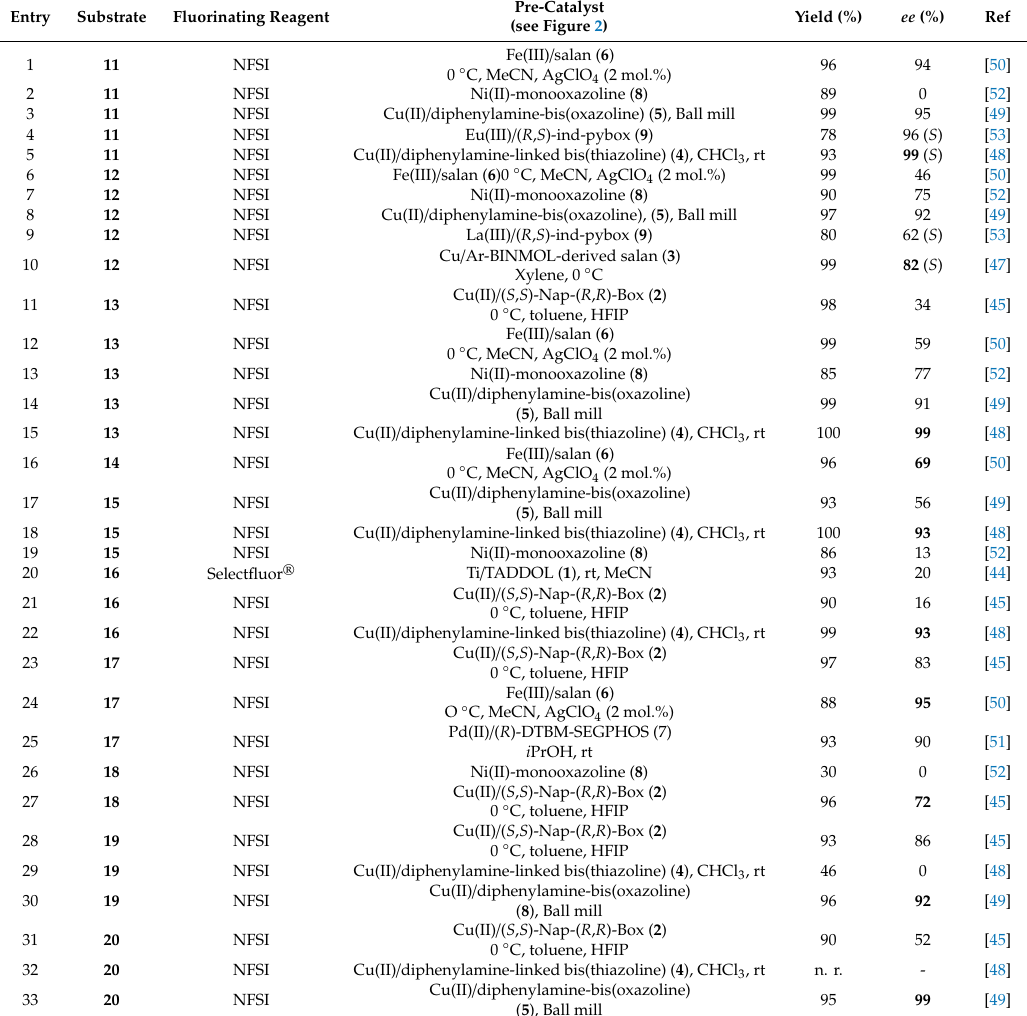
Table 1. Conditions and results for enantioselective fluorination reactions of compounds of Scheme 1 (from 2010 to